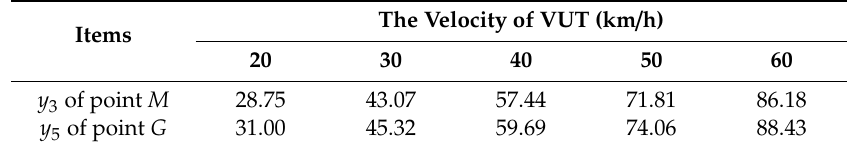
Table 3. The longitudinal coordinate values of Point M and vehicle center Point G at each test velocity. Items